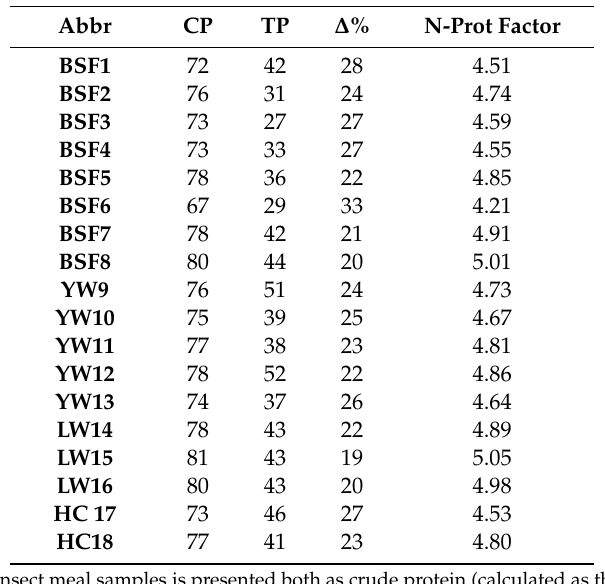
Table 4. Crude protein (CP, expressed as percentage of wet weight) and true protein (TP) content of 18 insect meal samples, and di ff erence between CP and TP ( ∆ %) and N-Prot conversion